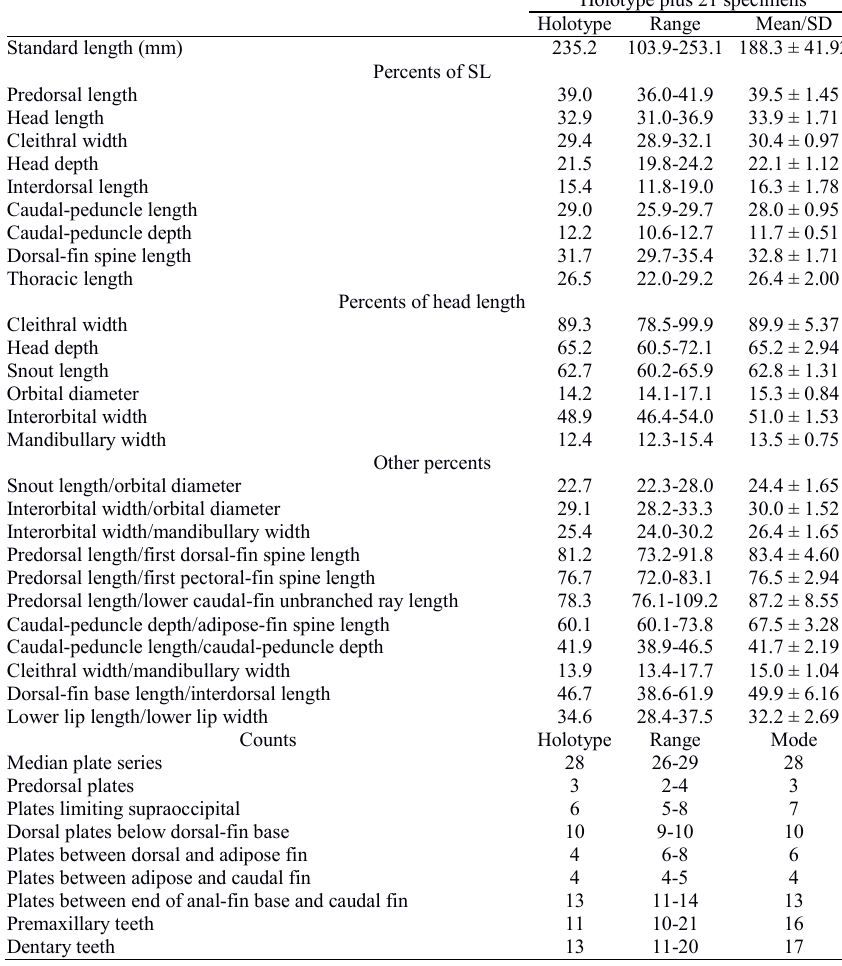
Holotype plus 21 specimens